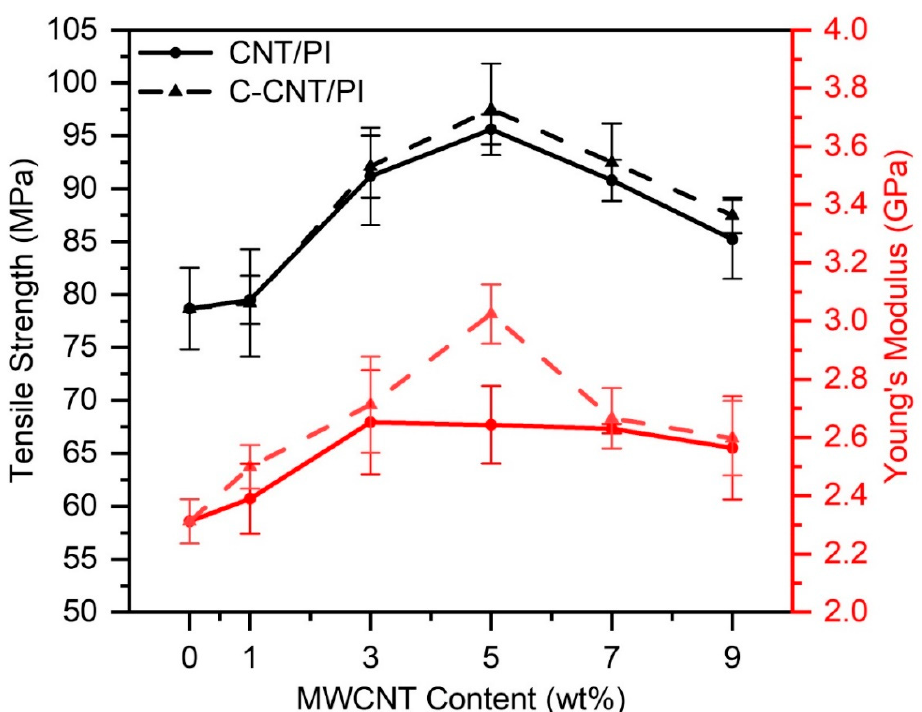
Figure 12. The tensile strength and tensile modulus of PI films with different contents of CNT and C-CNT. Table 7. The mechanical properties of PI, CNT/PI and C-CNT/PI films.